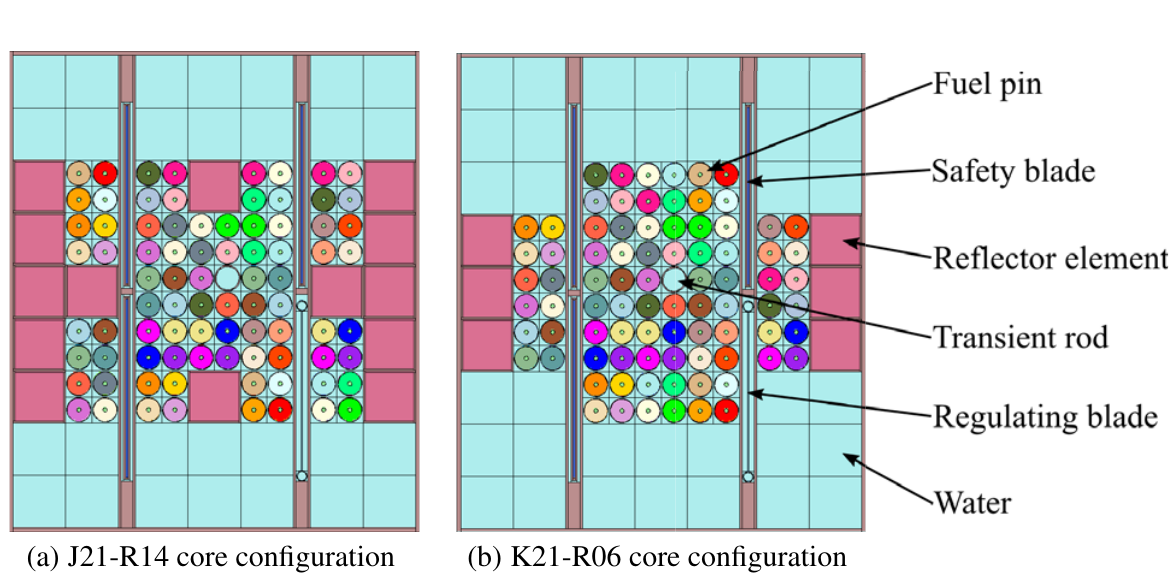
Figure 1: MCNP6-plotted geometry of UWNR core. Fuel pins are represented in various colors as they have different material numbers for burnup